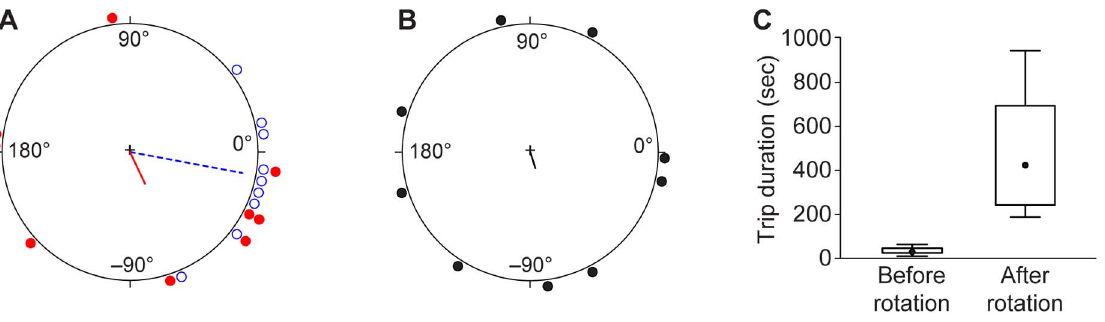
Figure 4. Substrate rotation plus blocking of visual cues causes disorientation. A) Before rotation (dashed blue line and open blue circles), headings were significantly directed (r=0.89, p=8 6 10 2 5 ) and average heading deviated 11 u from the direction of the new nest (0 u ). After rotation (solid red line and closed red circles), headings were highly dispersed, and the mean heading could not be distinguished from random (average heading = 2 65 u , r=0.27, p=0.53). B) The change in heading was extremely variable across ants and the mean angular change could not be distinguished from random (average change = 2 72 u , r=0.13, p=0.86). C) The duration of journeys from the old to the new nest increased sharply after blocking of visual cues (Wilcoxon paired ranks test: V=0, n=8, p=0.0078). See Figure 2 for box plot details.